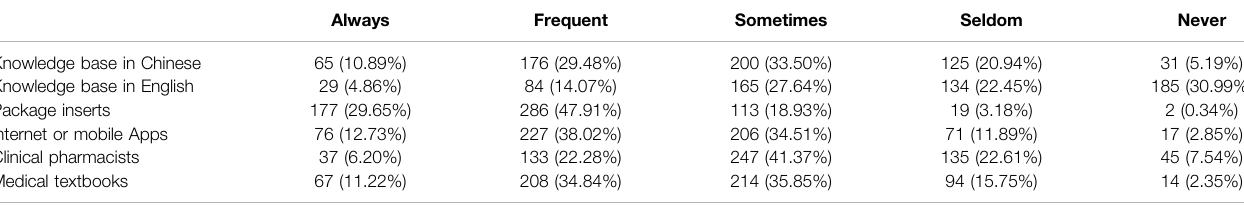
TABLE 3 | Identi fi ed barriers against appropriate prescribing for the elderly.